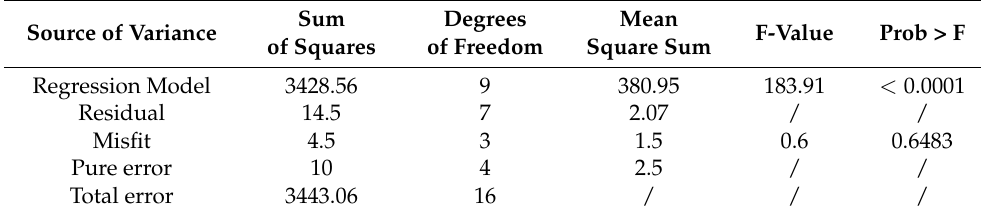
Table 6. Regression equation analysis of variance table.